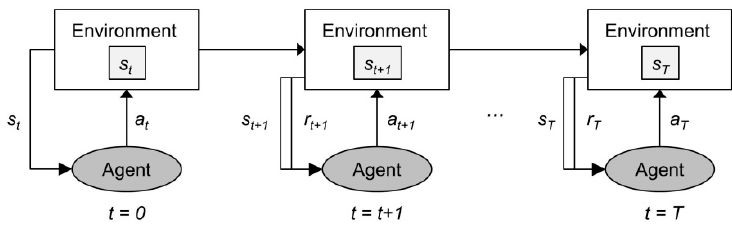
Figure 4. The agent-environment interaction in a Markov decision process (MDP). The agent and the environment interact over a sequence of discrete time steps t = 0, 1, 2, ... . At each time step t the agent receives a representation of the state of the environment at that time step s t and performs an action a t . In response to the action of the agent the environment transitions to the next state s t + 1 . At the next time step t + 1 the agent receives a numerical value (or reward) r t + 1 assessing its performance and uses this information together with the current state s t + 1 to choose its next action a t + 1 .